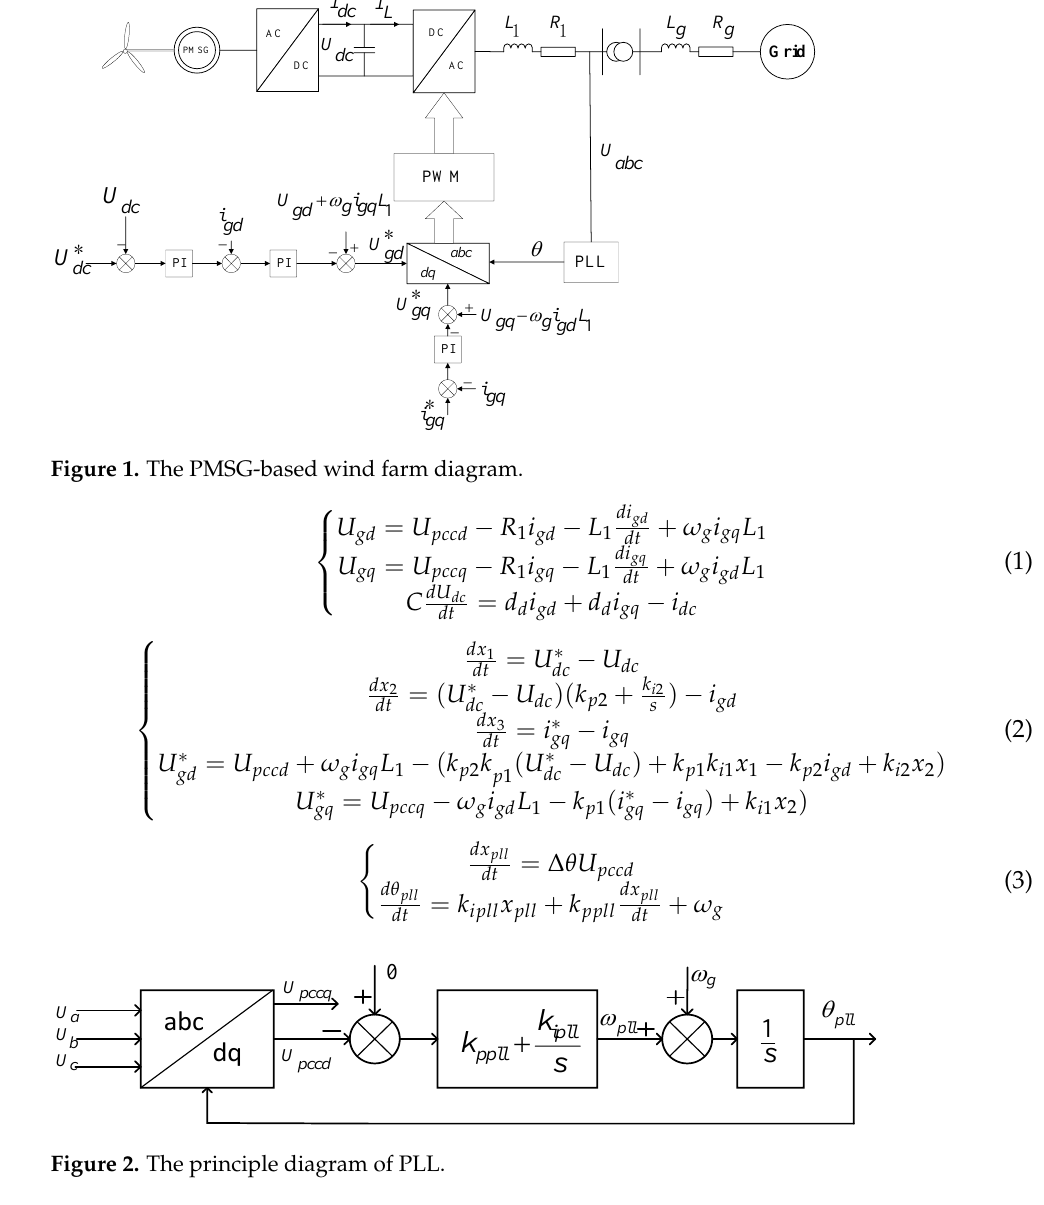
+ Figure 1. The PMSG-based wind farm diagram.